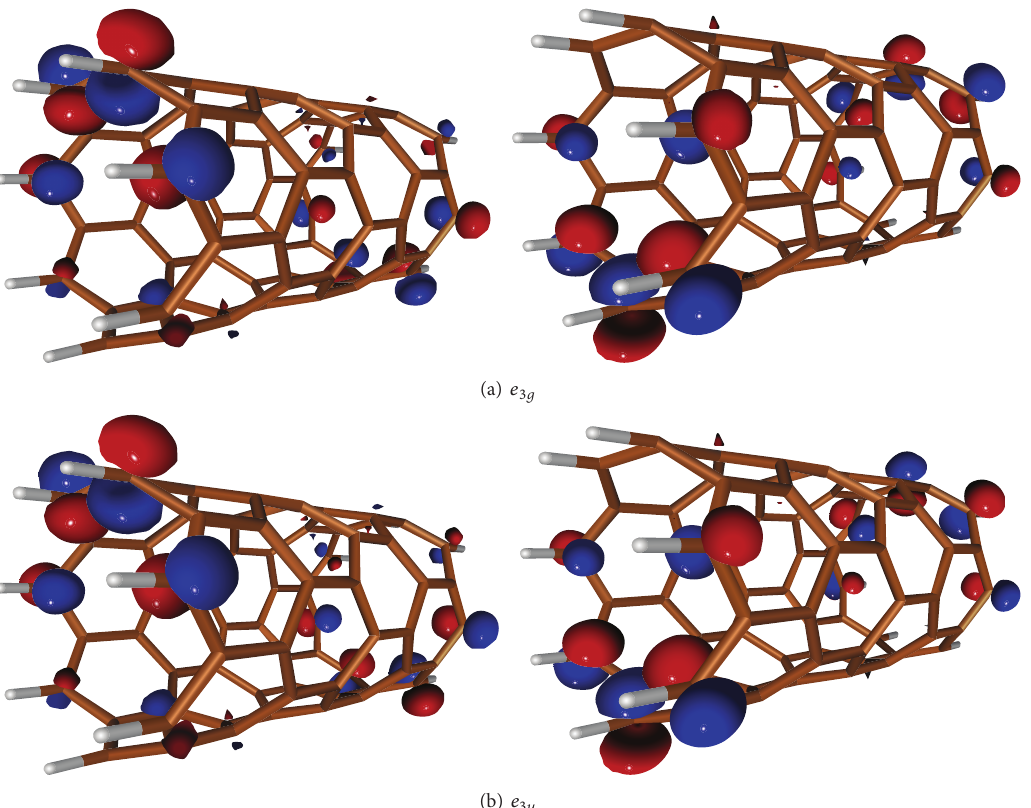
Figure 8: Active orbitals of nanotube (7 4) as an example of nanotubes with 𝑛 odd and 𝑝 even.